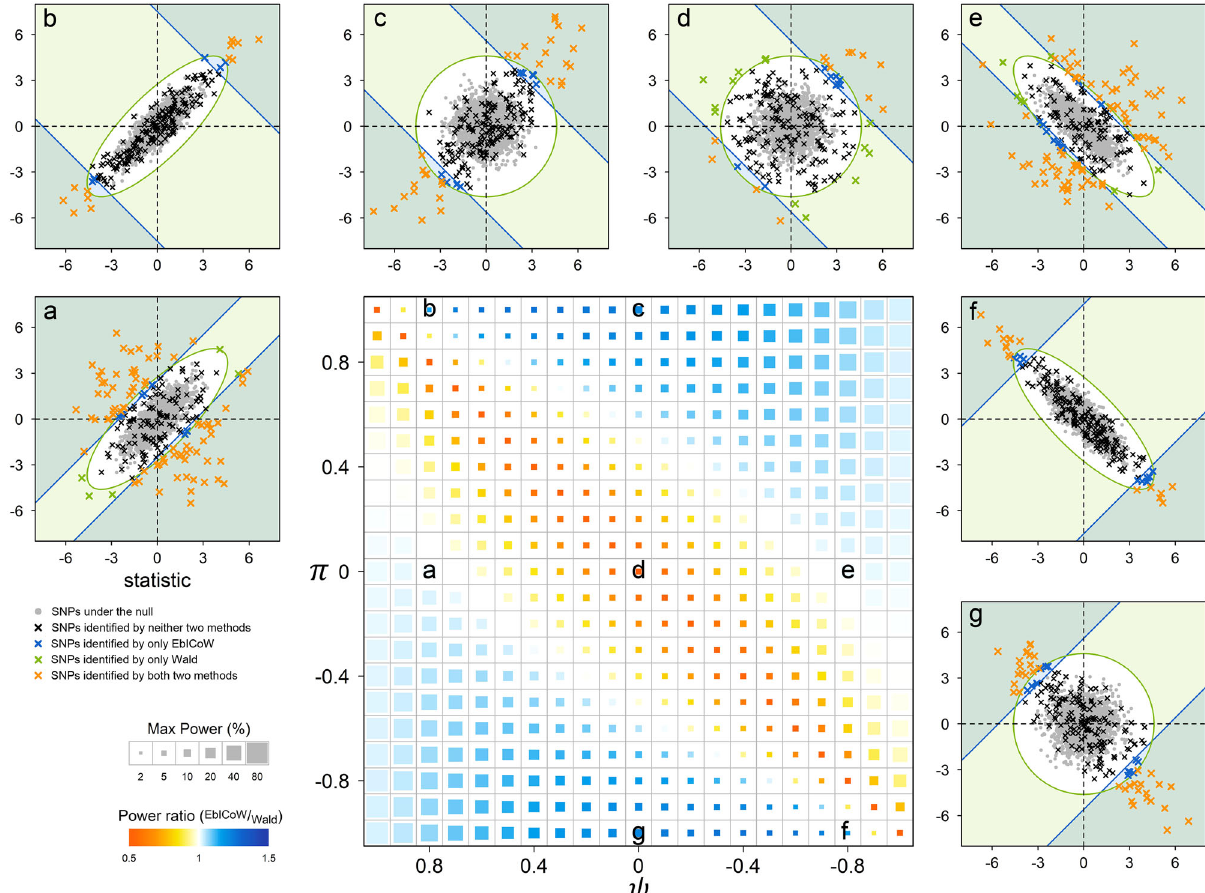
Fig. 1 | Power comparison between EbICoW and Wald test for combining two GWASsunderthesametrueeffectviasimulations. Thesummarystatisticsoftwo GWASswiththesametrueeffectcon fi guration,i.e.,E( χ 2 )=1.3,weresimulated,each consisting of 50,000 SNPs with 10% having true effect, according to the following parameter grid: ψ and π 2 { − 0.98, − 0.9, − 0.8, … , − 0.1, 0, 0.1, … , 0.8, 0.9, 0.98}. For each of the 441 (21×21) different combinations of π and ψ , 1000 replicates were carriedout.ThepowerrelationshipbetweenEbICoWandWaldisillustratedusinga heat map in the center panel. The maximum power of the two methods is pro- portionaltotheblocksizeinthe heatmap. ThepowerratioofEbICoWand Wald is expressedbycolorfromredtoblue.Takingsevenspeci fi ccombinationsof π and ψ